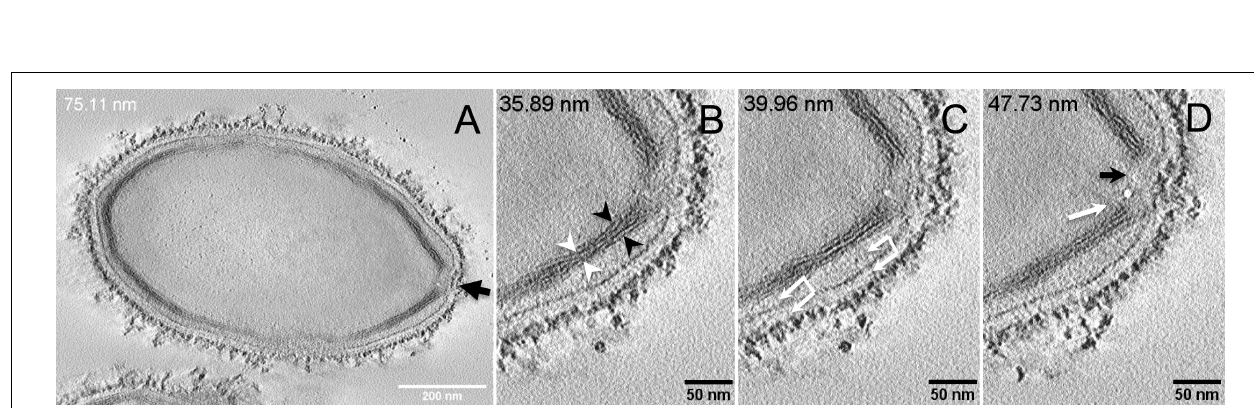
Frontiers in Microbiology |